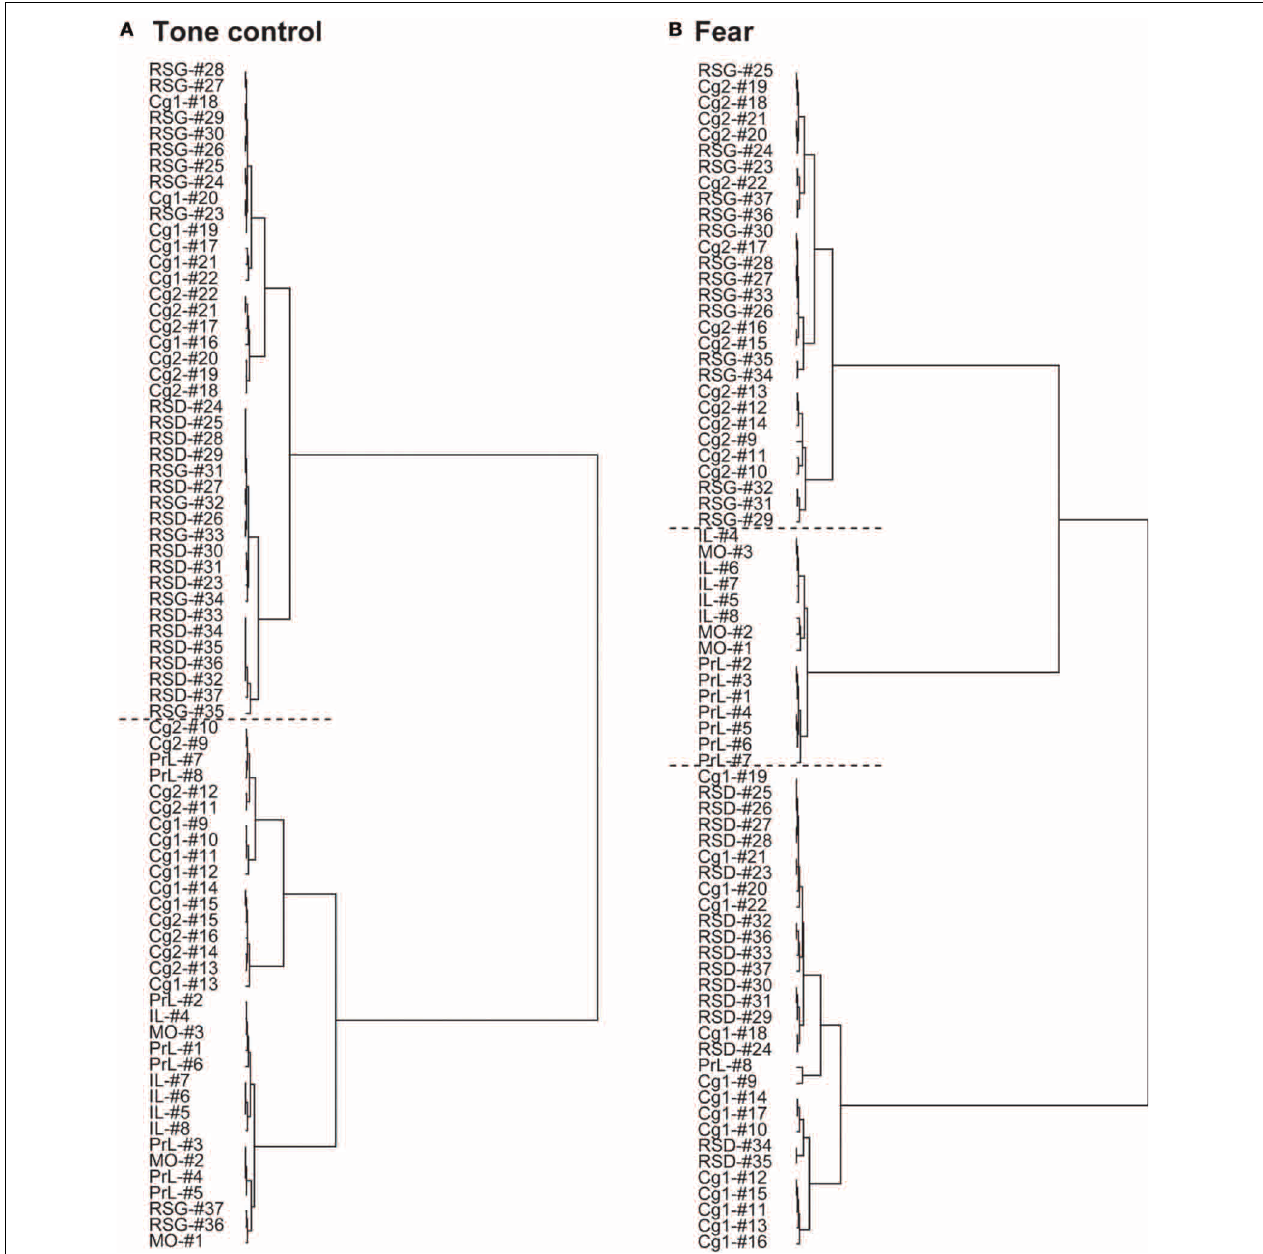
FIGURE 3 | Differences in hierarchical clustering between the control and fear-conditioned mice. (A) Control mice exposed to a neutral tone. (B) Fear-conditioned mice during auditory-cued fear recall. The dendrograms show hierarchical clustering of the functional networks of the cortical midline structures. Dissimilarity between two regions-of interest (ROIs) is represented by the horizontal distance to their nearest joining point. Horizontal dashed lines are used to separate main clusters. Abbreviations: